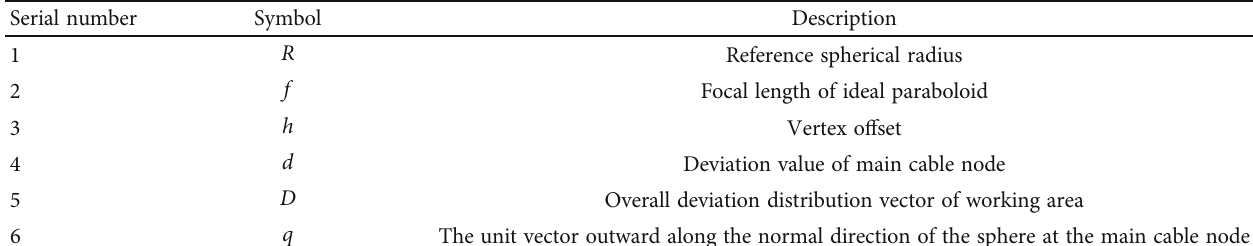
Table 1: Symbol description.